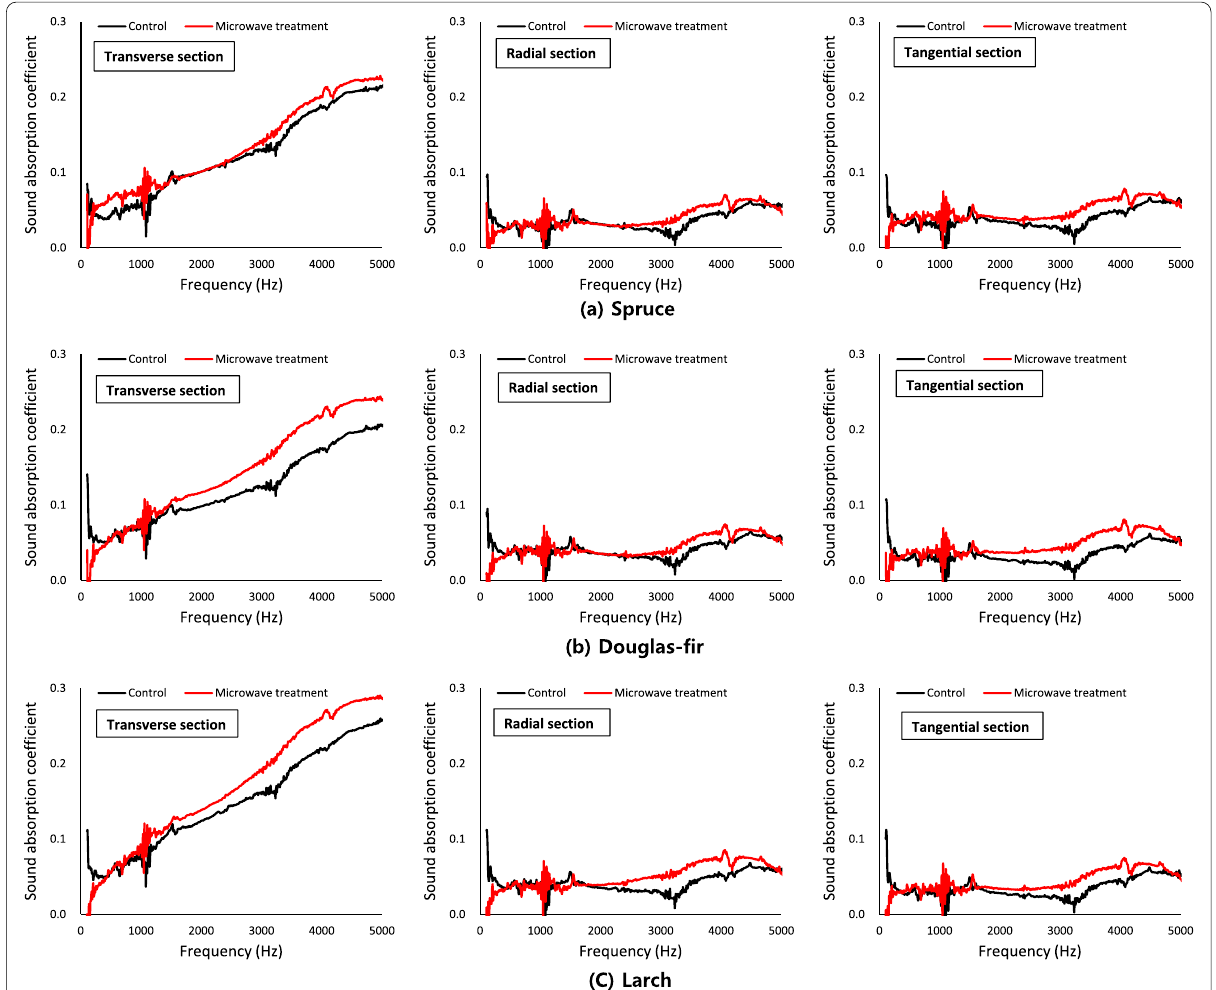
Fig. 3 Sound absorption curves of three softwood species before and after microwave treatment depending on anatomical direction